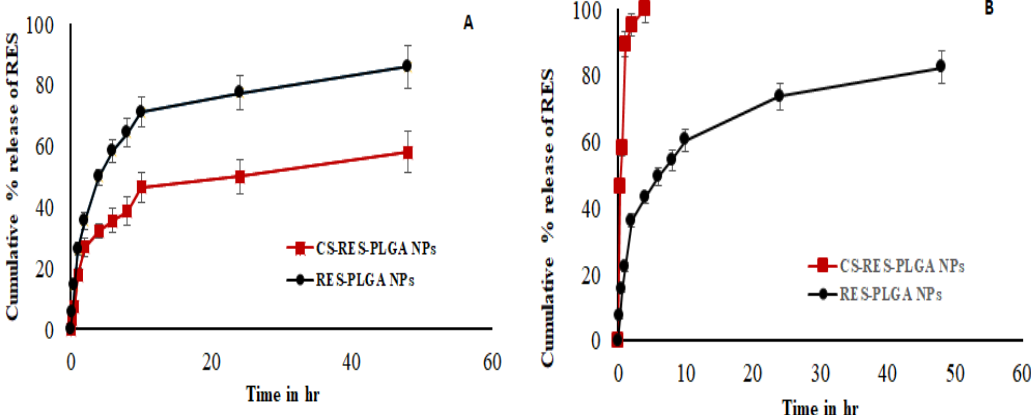
Figure 7. In vitro release profiles of RES from RES-PLGA NPs and CS-coated RES- PLGA NPs at pH 7.4 (panel A ) and at pH 5.5 (panel B ) (The temperature was set at 37 °C, mean ±SD, n =